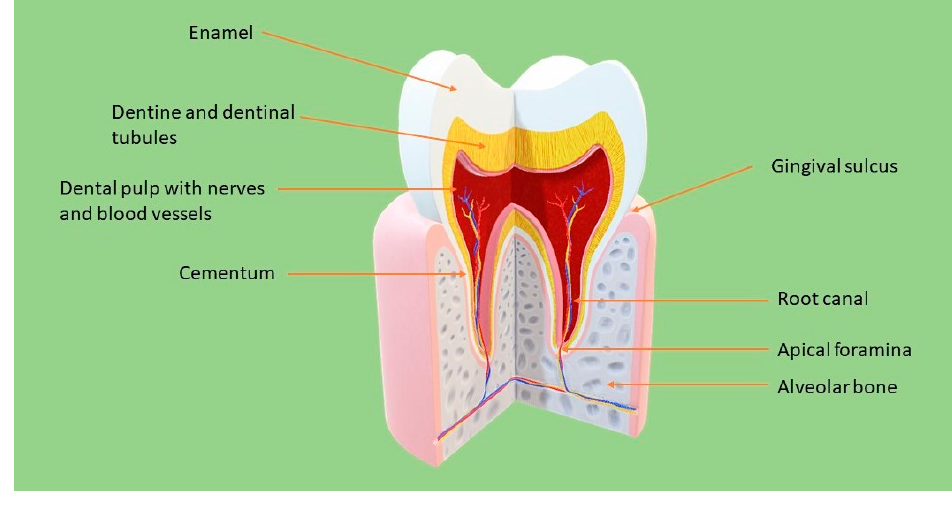
Figure 1. Molar anatomy.